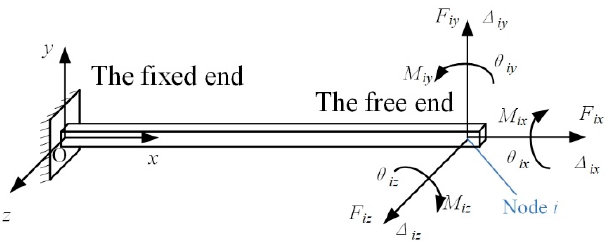
Figure 1. The coordinate system and load–displacement relationship of a spatial flexure hinge.